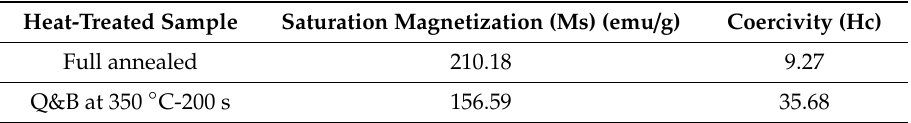
Figure 9. The comparison of VSM curves showing the variation of magnetization versus applied field in the full annealed and Q&B isothermally heat-treated samples at 350 ◦ C for 200 s. Table 5. The variation of magnetic parameters extracted from the VSM curves shown in Figure 8.